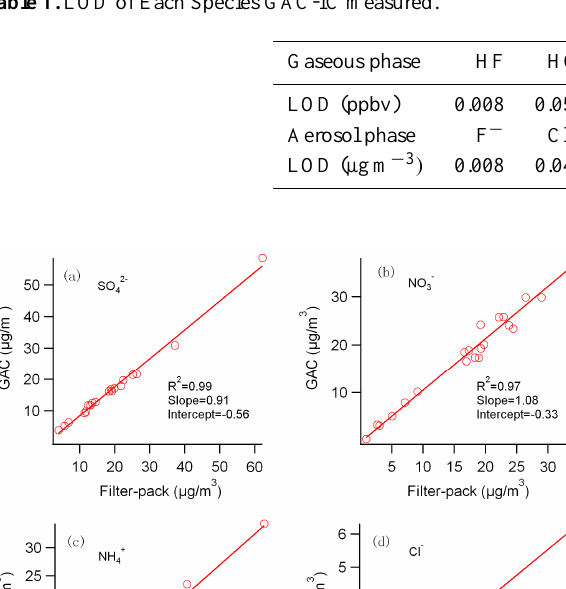
Table 1. LOD of Each Species GAC-IC measured.